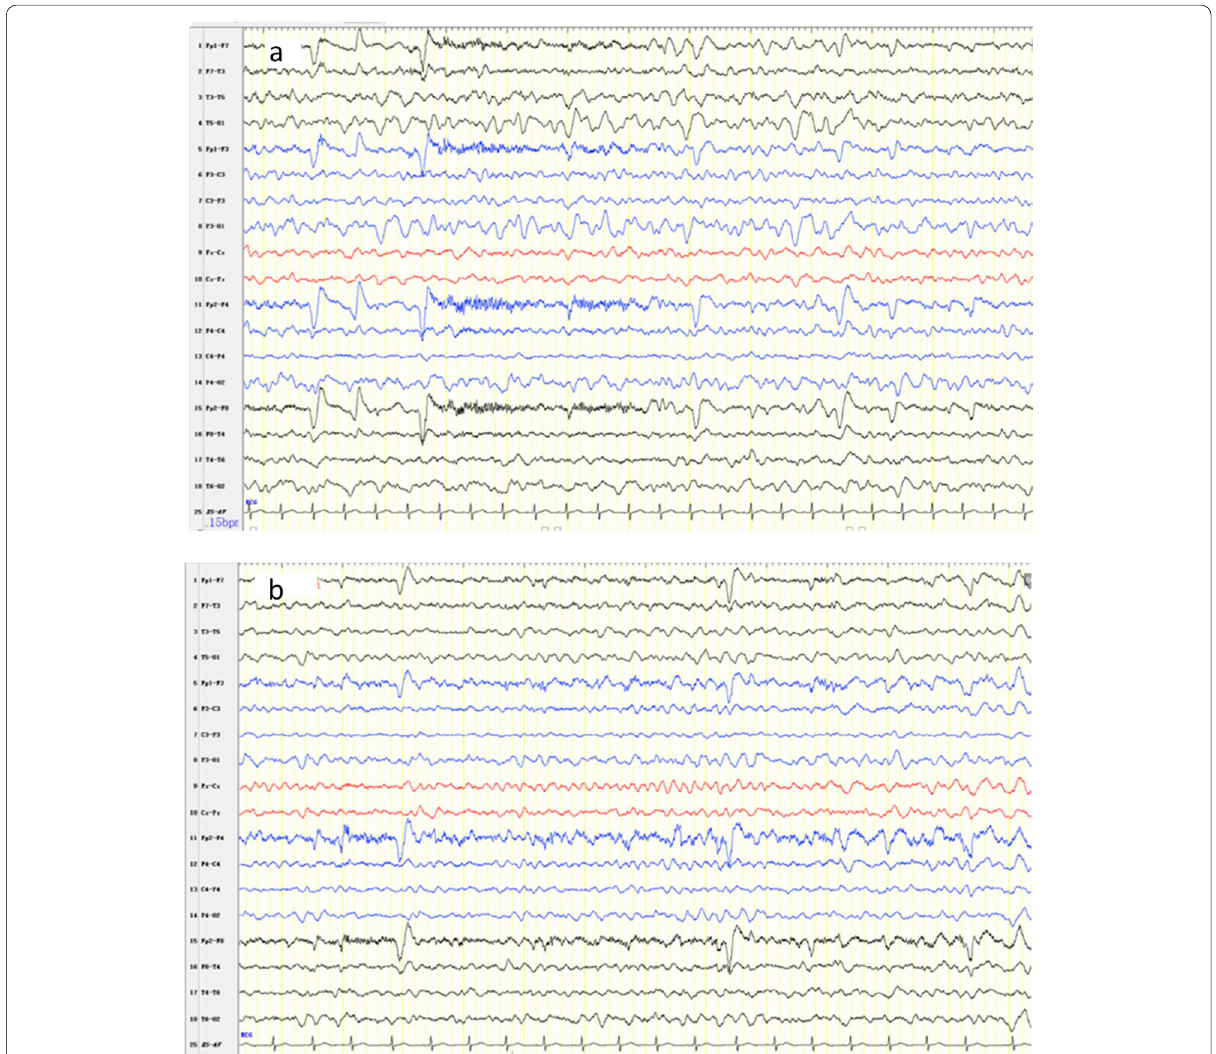
Fig. 3 Electroencephalographic monitoring. a At 7 years, immediately before VNS implantation, EEG showed central-occipital dominant background slowing. b At 8 years, ~ 1 year after VNS initiation, EEG showed improvement in background